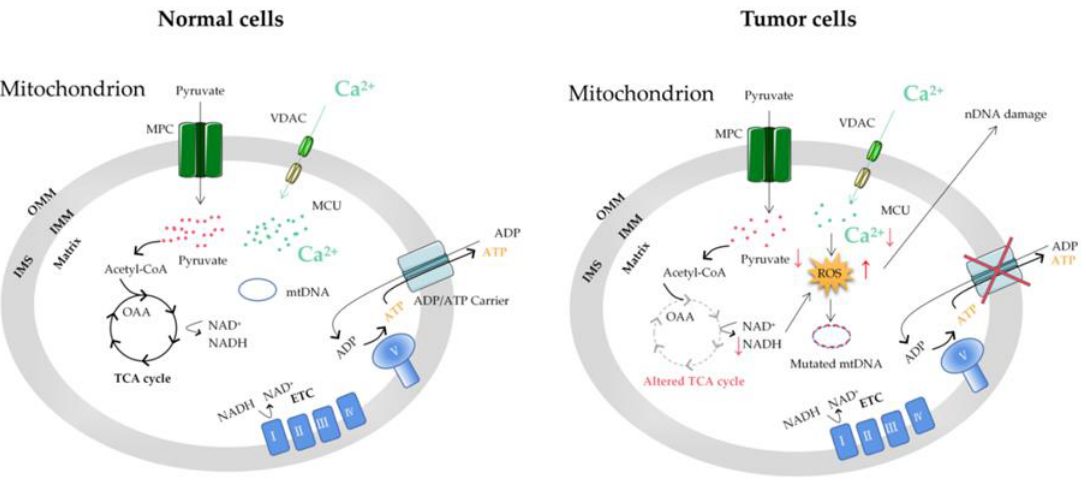
Figure 3. The mitochondrial Ca 2+ and energy metabolism in normal and tumor cells. The reprogramming of energy metabolism, including energy production disorders caused by cell respiratory defects, is the core symbol of cancer. The change in energy metabolism in cancer cells is related to the abnormal function of mitochondria. Accumulation of the ROS induced by mitochondrial Ca 2+ dyshomeostasis and altered TCA in tumor cells can cause mitochondrial DNA (mtDNA) and nuclear DNA (nDNA) mutations. MCU, mitochondrial calcium uniporter; VDAC, voltage-dependent anion-selective channel; ETC, electron transport chain; OMM, outer mitochondrial membrane; IMS, intermembrane space; IMM, inner mitochondrial membrane; MPC, mitochondrial pyruvate carrier; OAA, oxaloacetic acid; TCA cycle, tricarboxylic acid cycle.